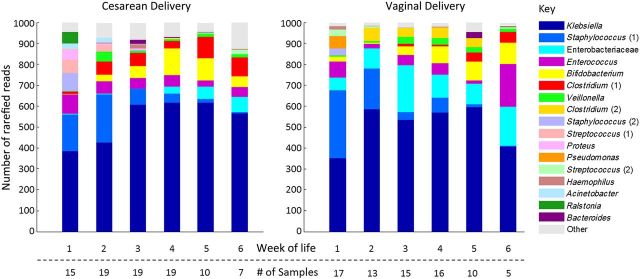
Bacterial community structure in control infants by postnatal week and mode of delivery. Data were generated using 1 sample per week from control infants using mean number of reads. When the same descriptive label (genus, family) is attached to >1 operational taxonomic unit (OTU; defined by 97% sequence similarity), these are numbered sequentially; no OTUs are combined.